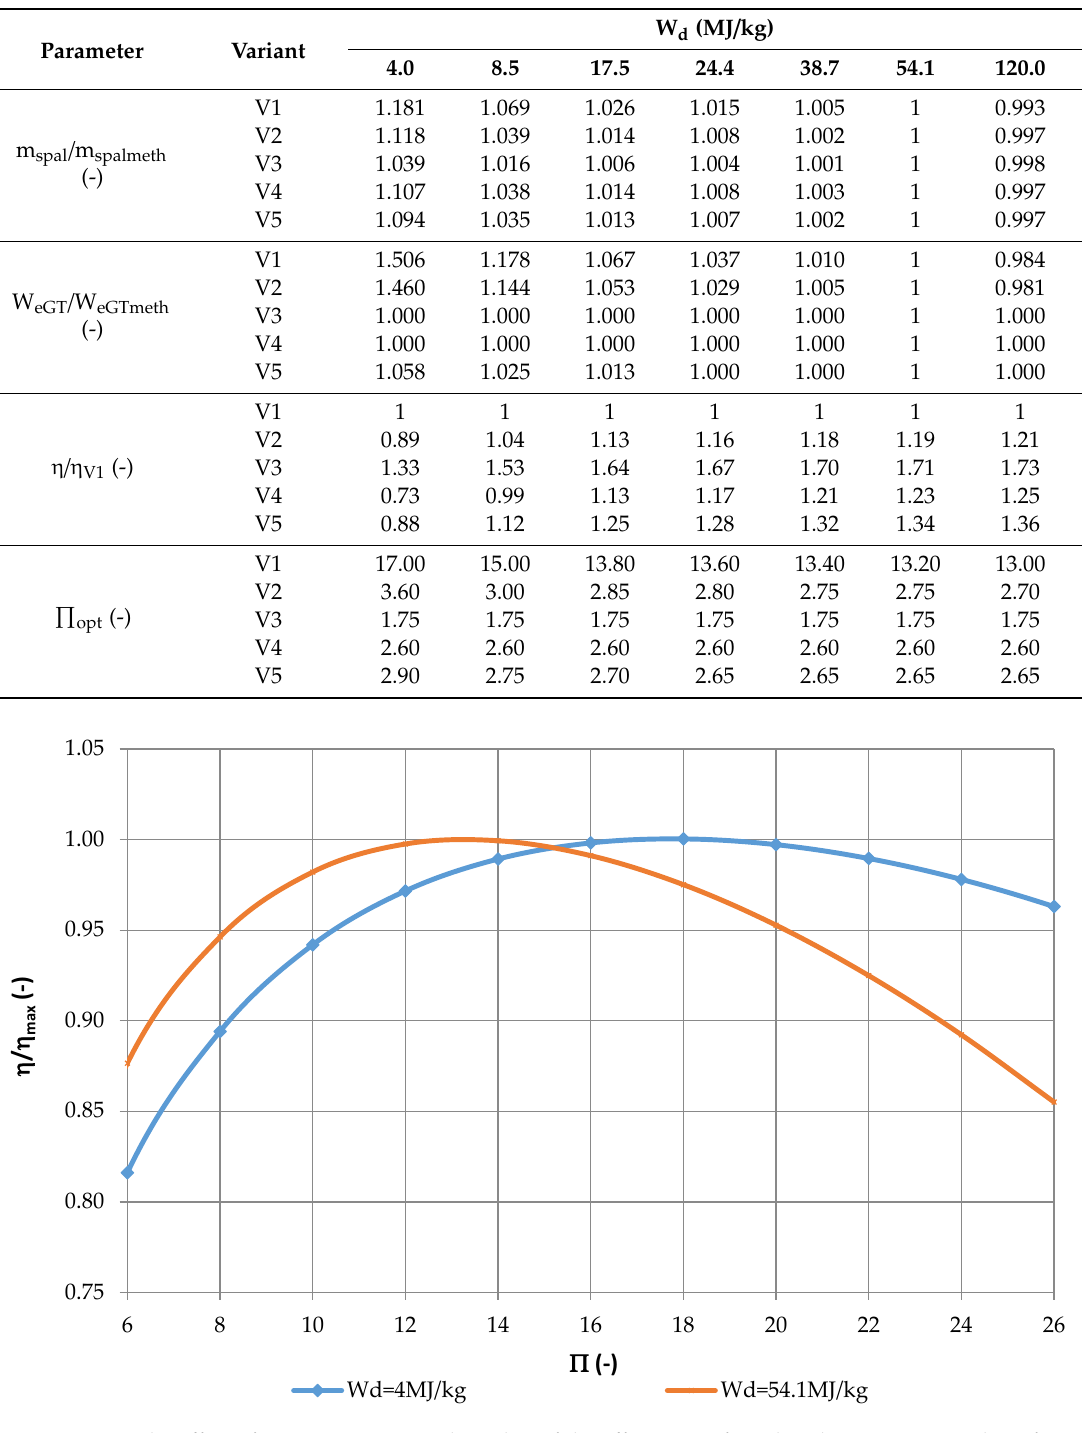
Figure 3. Influence of the structure of the cycle and calorific value of fuel on the optimal compression.